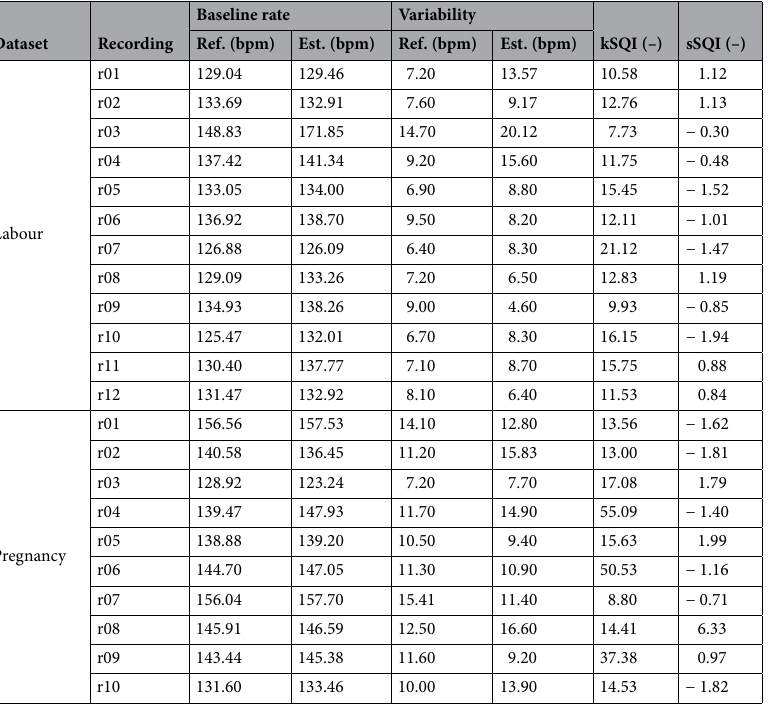
Table 3. Result of Basal fHR, fHR fluctuations, Kurtosis and skewness analysis for the labour dataset and the pregnancy